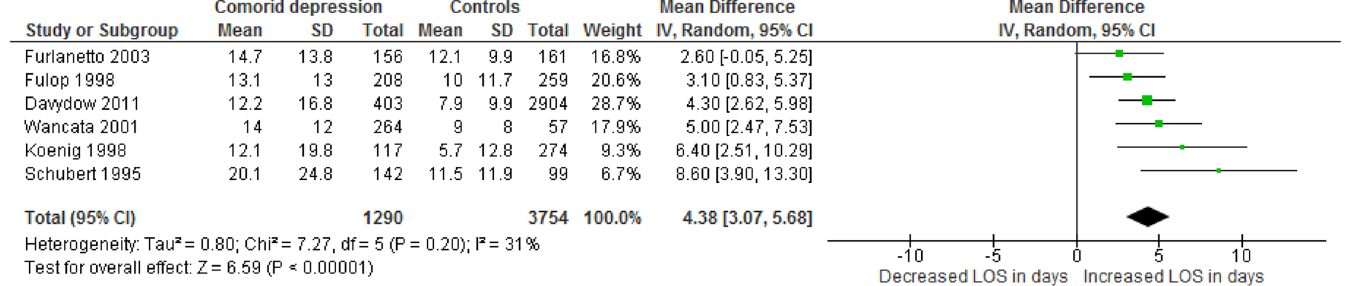
PLOS ONE | https://doi.org/10.1371/journal.pone.0194029 March 13,